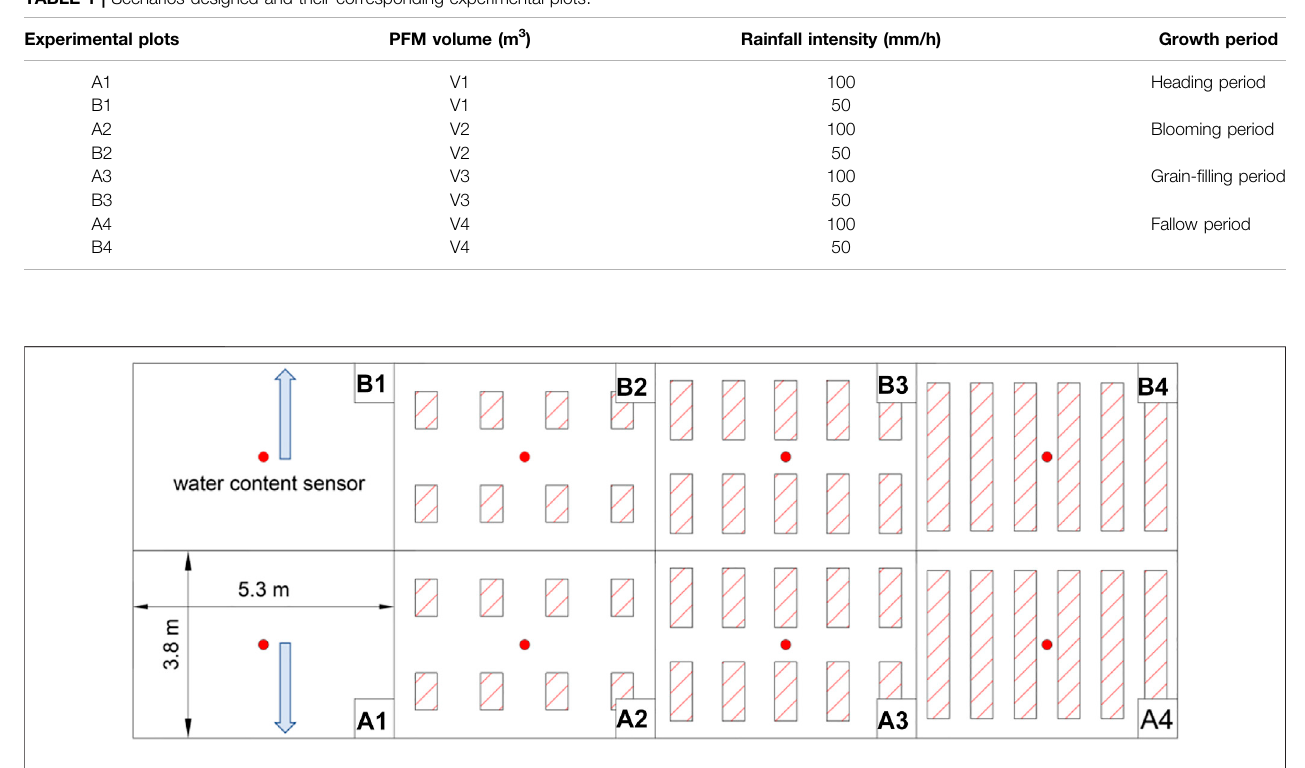
FIGURE 3 | Location of the porous- fi ber module in plots and their direction of the slope. A1, A2, A3, and A4 are the experimental plots under 100 mm/h rainfall intensity;B1,B2,B3,andB4aretheexperimentalplotsunder50 mm/hrainfallintensity;thearrowrepresentsthedirectionofslope,A1~A4plotshavethesamedirection of the slope; B2-B4 plots are the same as the B1